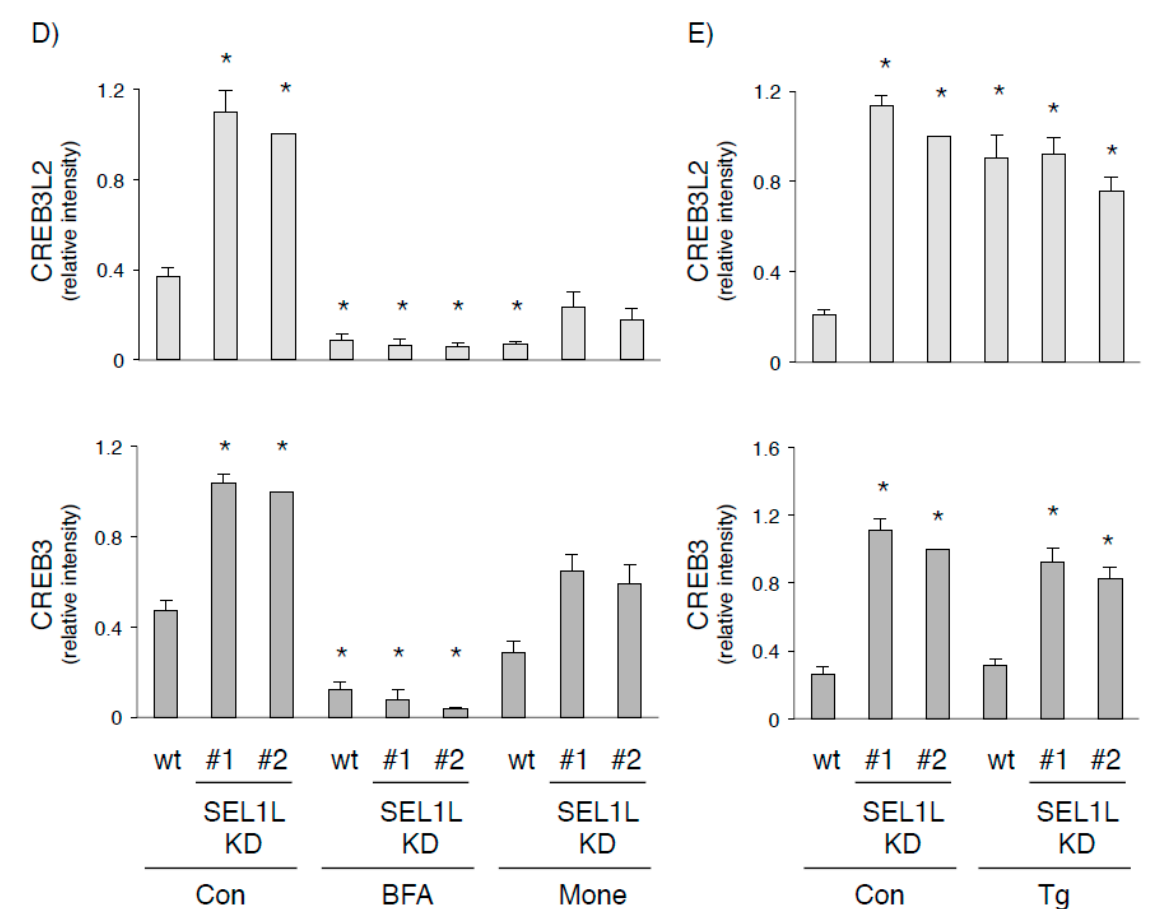
Figure 2. SEL1 deficiency increased CREB3 and CREB3L2 protein expression in HEK293 cells. ( A ) Wild-type (wt) and SEL1L-deficient (SEL1L-KD) HEK293 cells were cultured ( A ) and treated with BFA (0.5 μ g/mL), monensin (1 μ M), Tg (0.01 μ M), Tm (2 μ g/mL), or vehicle for 6 h ( B – E ). The expression of the indicated protein was detected as described in the Materials and Methods. Open and filled arrowheads indicate full-length mature and cleaved CREB3 and CREB3L2 proteins, respectively. Representative results of three independent cultures are shown. ( D , E ) The relative amounts of full-length CREB3 and CREB3L2 were evaluated as described in the Materials and Methods. The level of each full-length form in untreated SEL1L-deficient cells (#2) was considered “1”. Each value represents the mean ± SEM from three independent cultures. Values marked with asterisks are significantly different from value of untreated wild-type cells (* p < 0.05).